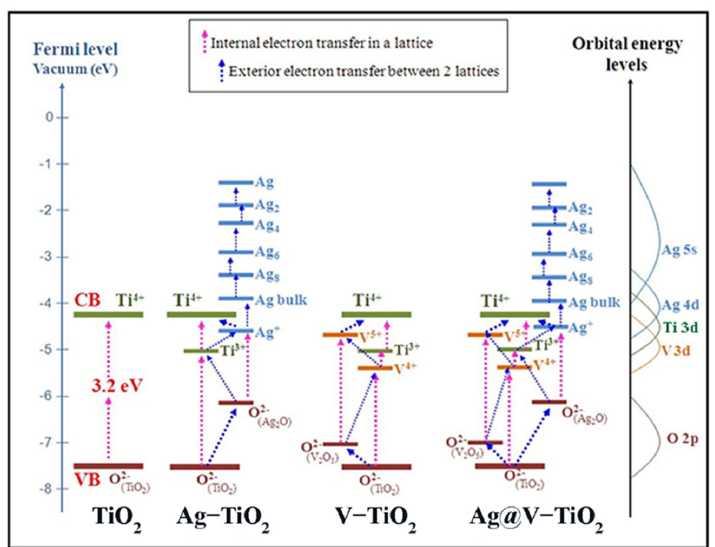
Figure 3. Mechanism of electron transfer in TiO 2 and doped TiO 2 materials. (Reprinted with permission from Ref. [60]. Copyright 2017, copyright Elsevier).